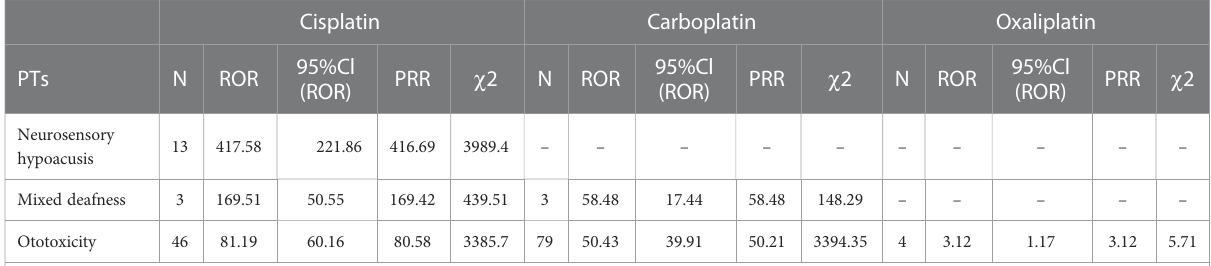
TABLE 9 Ear and labyrinth disorder-related adverse events of Cisplatin, Carboplatin and Oxaliplatin.